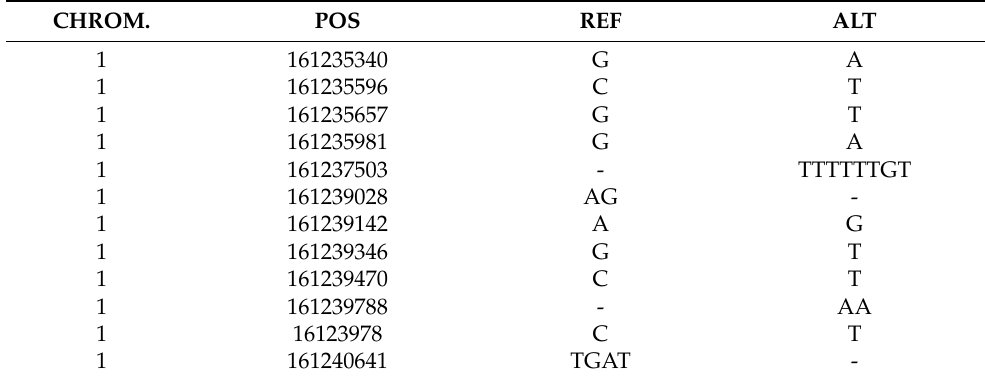
Table 1. VCF file format of hybrid HE